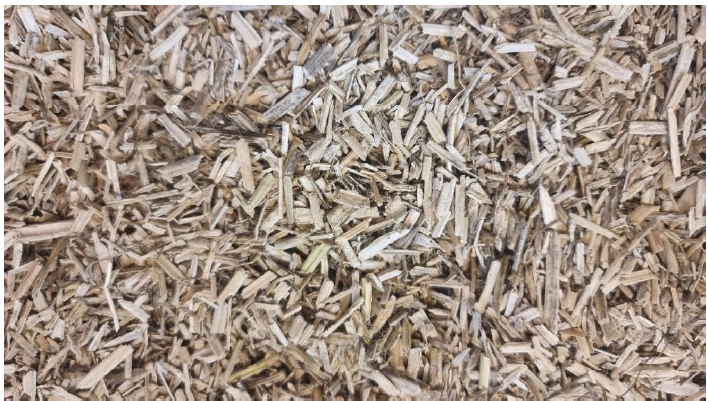
Figure 1. Hemp shives used as a filler.